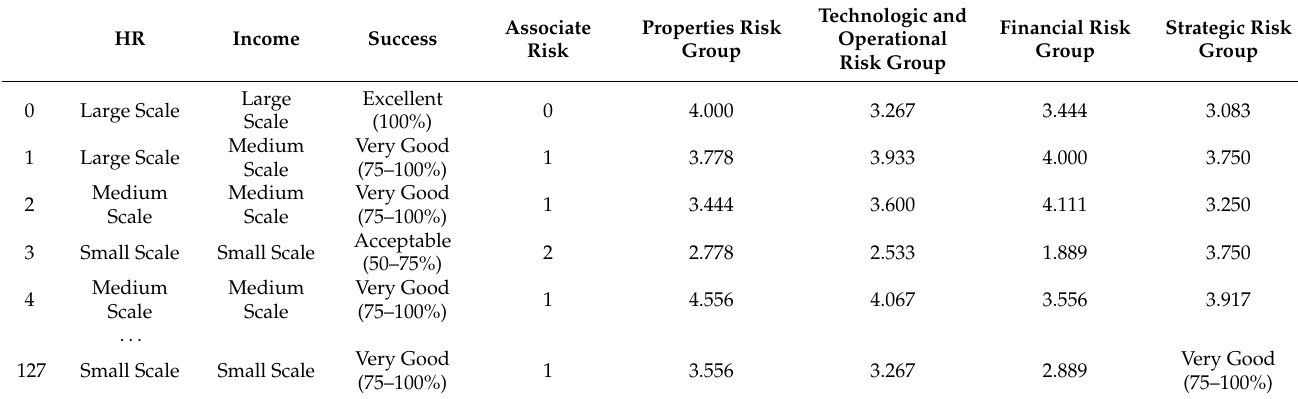
Table 3. Dataset summary that was used for the hybrid PCA-agglomerative